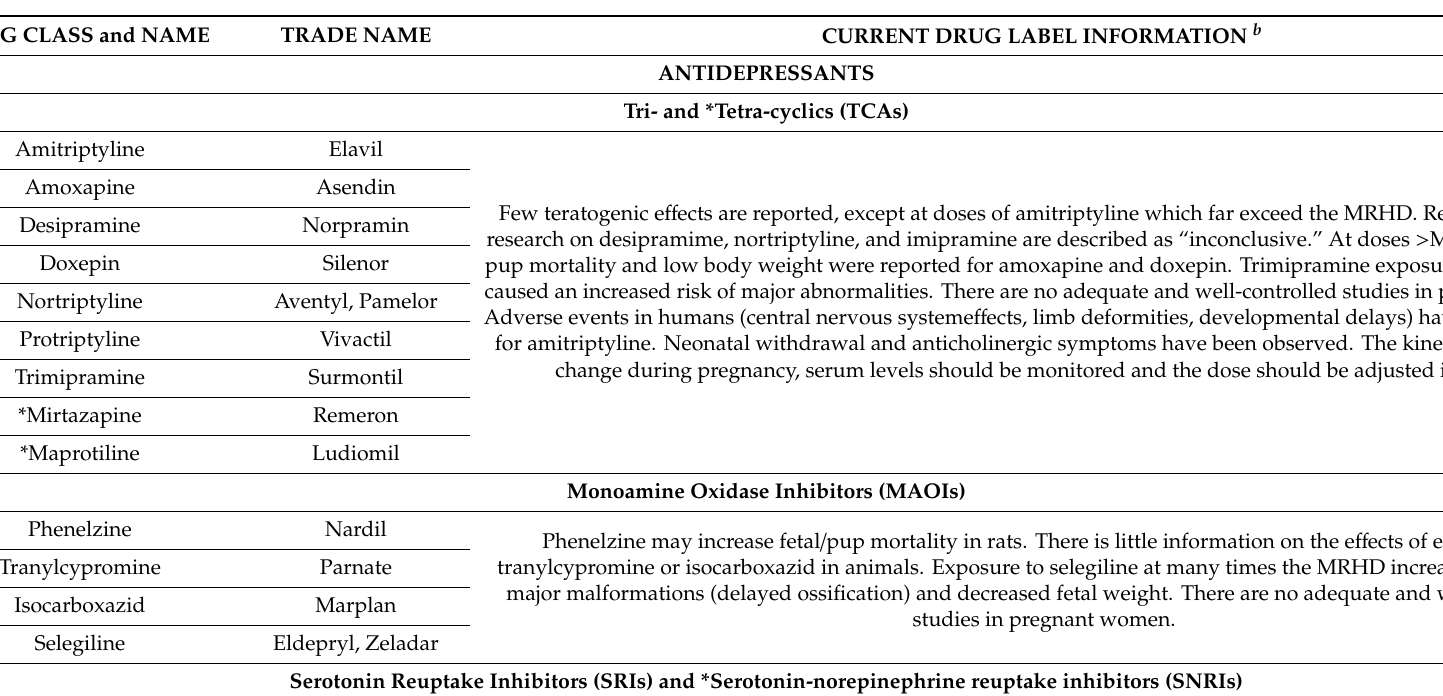
Table 3. Drugs approved by the FDA to treat depression, anxiety and sleep disorders, according to class of drug, the trade name used in the U.S. market, and the FDA pregnancy category assigned to each. The drug label information regarding pregnancy risk, as provided by the drug manufacturer, is summarized for the animal and human data, which often involves experiments using the maximum recommended human dose